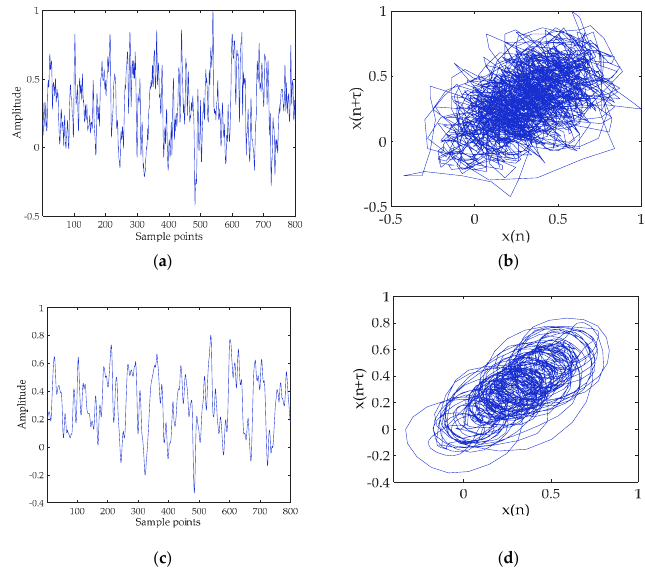
Figure 13. Ship-II and denoised Ship-II signals and their attractor trajectories. ( a ) Ship-II (select 800 points); ( b ) attractor trajectory for Ship-II; ( c ) denoised Ship-II (select 800 points); and ( d ) attractor trajectory for denoised Ship-II.